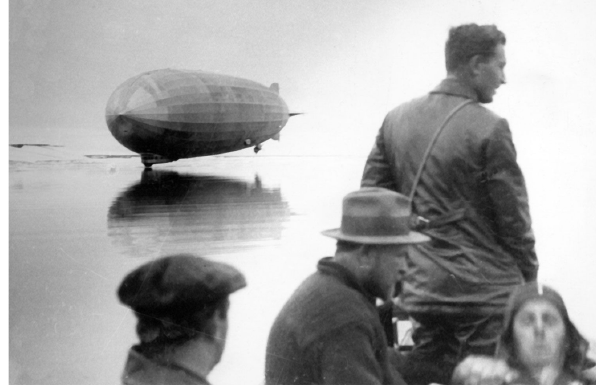
Figure 2. Graf Zeppelin descending to the water surface near Franz Josef Land. Umberto Nobile is standing in the